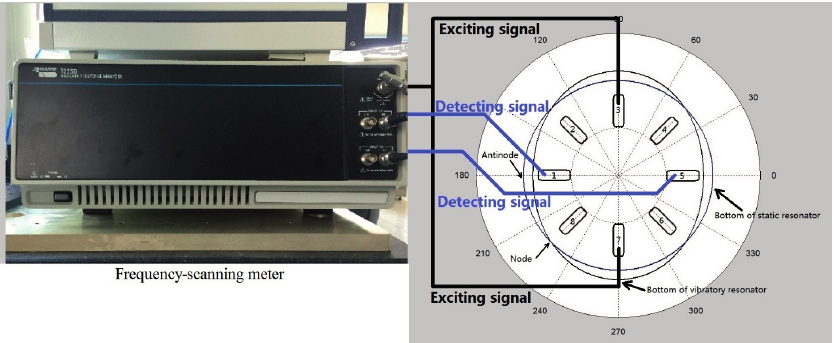
Figure 12. The real resonator and piezoelectric patches.